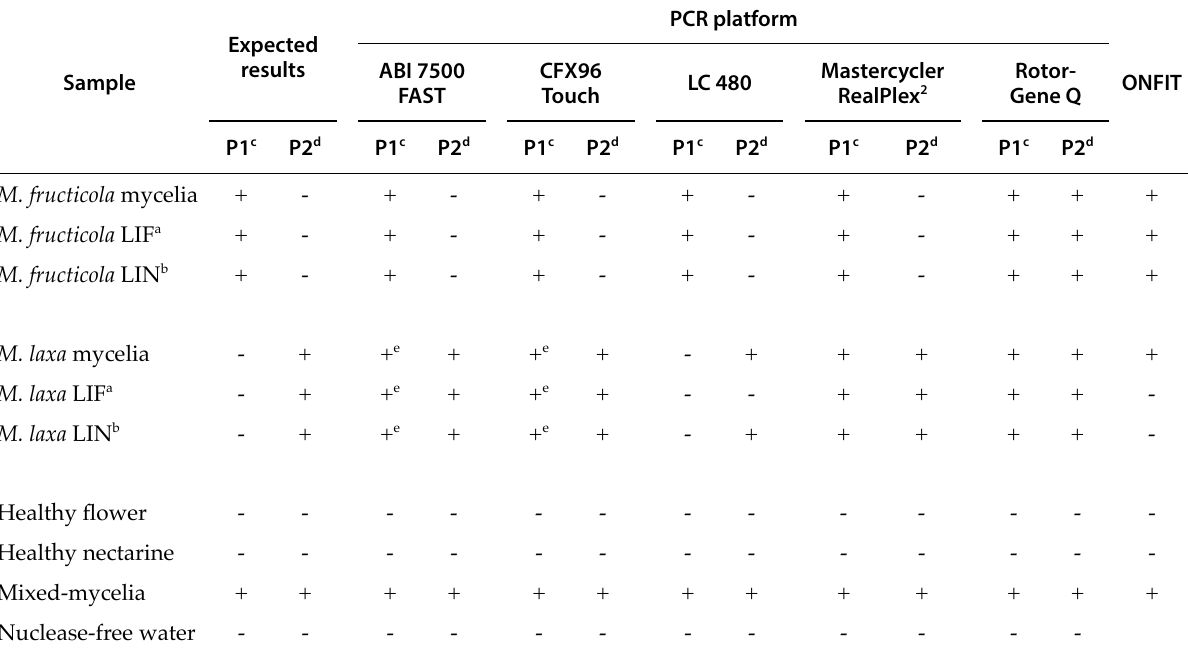
Table 1. Qualitative results of the qPCR assays of blind Monilinia and “healthy” samples, performed by five participating laboratories with different real-time PCR platforms for each hydrolysis